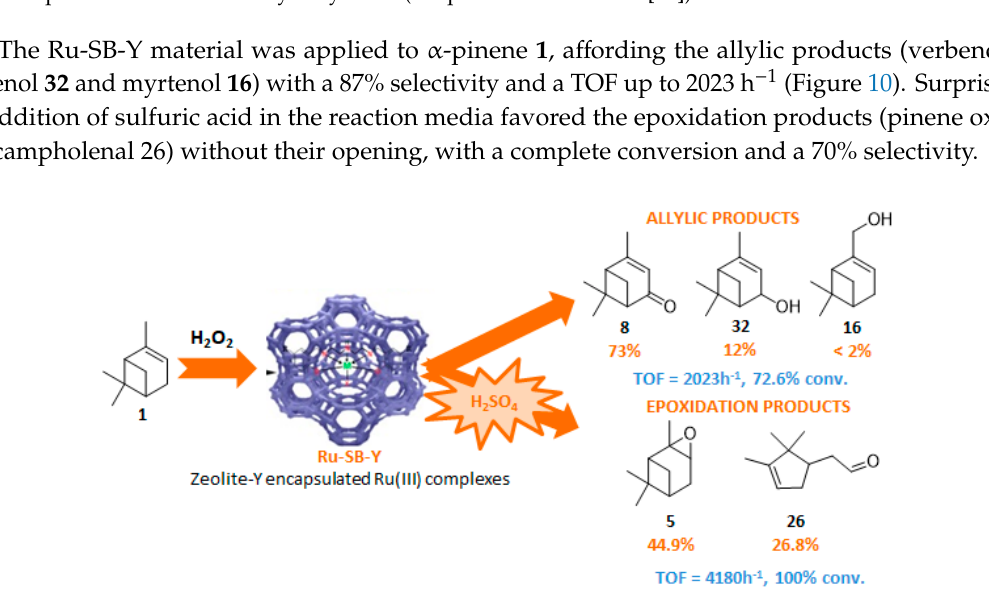
Figure 9. Allylic oxidation of limonene with zeolite-Y encaged Ru(III) and Fe(III) complexes. Comparison of various catalytic systems (adapted from reference [64]).